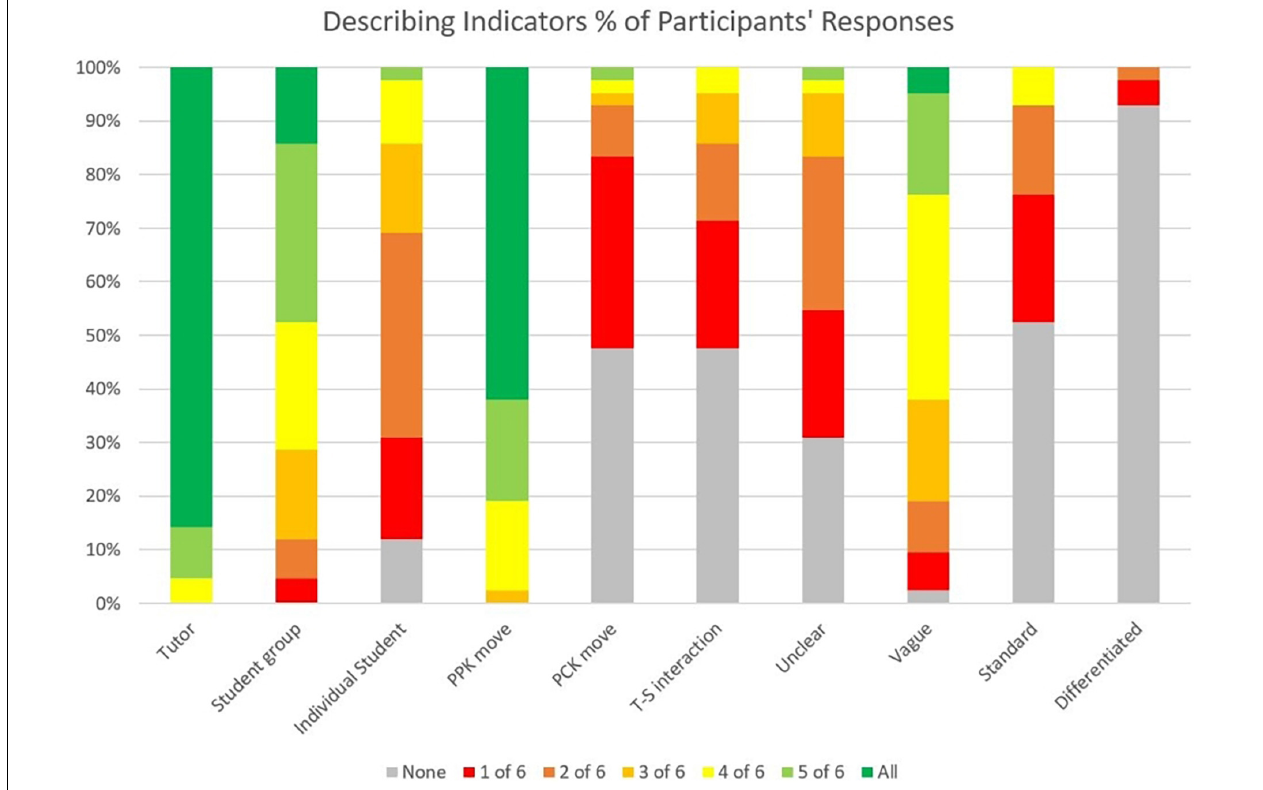
FIGURE 2 | Proportion of describing indicators within participants’ responses. Teacher students’ made a total of six different video analyses. The Figure shows the proportion of each describing indicator present across all six descriptions of each participant. Response proportions are depicted with a red-yellow-green color scale to represent fewer to more presence of an indicator across a participants’ six responses. Indicator bars demonstrate the distribution of these proportions across all participants. Results based on 240 responses from 42 participants (6 responses per participant, 12 missing responses).